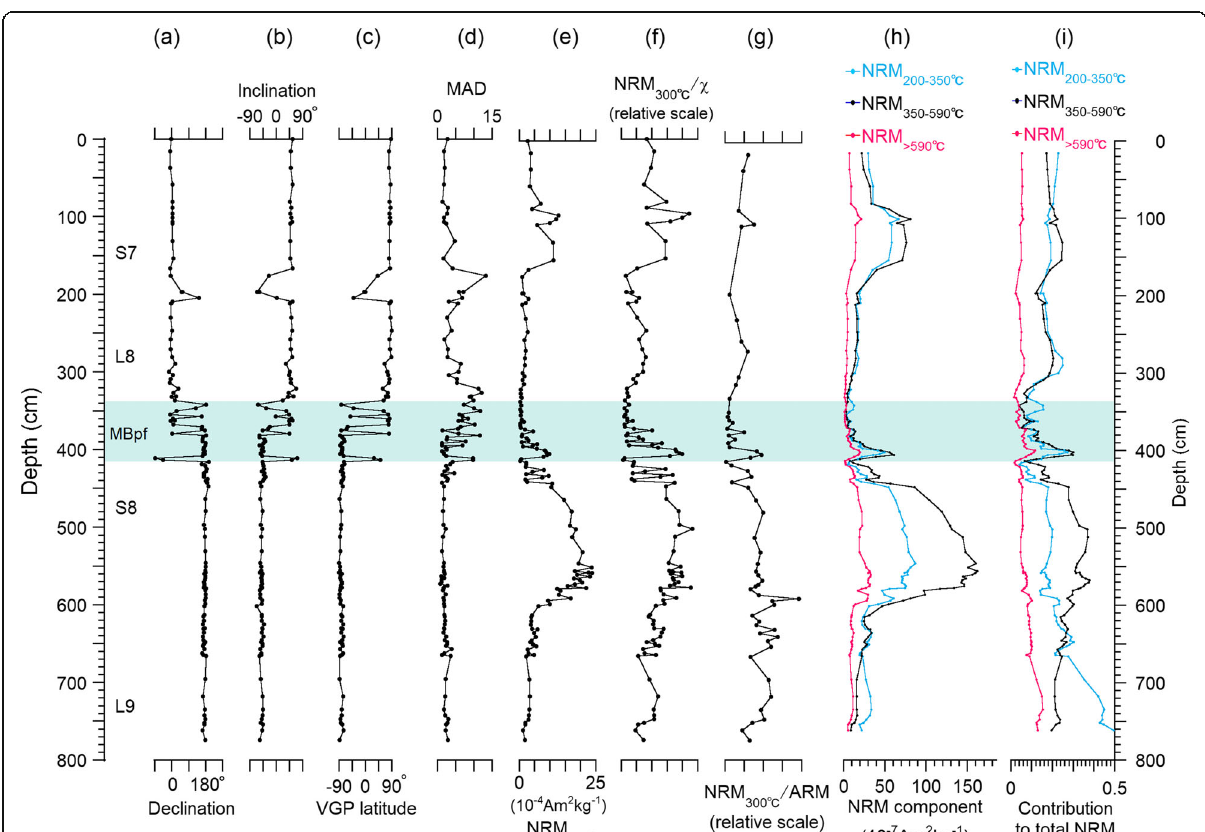
Fig. 4 Paleomagnetic results. a , b Declination and inclination of a ChRM calculated by the principal component analysis. c Latitude of a VGP calculated from the ChRM direction. d MAD (Kirschvink 1980) of the ChRM. e Intensity of NRM after demagnetization at 300 °C (NRM 300 °C ). f Intensity of NRM 300 °C normalized by magnetic susceptibility χ . g Intensity of NRM 300 °C normalized by ARM. h NRM components of temperature ranges of 200 – 350 °C, 350 – 590 °C, and > 590 °C. i Contribution to the total NRM of the components of temperature ranges of 200 – 350 °C, 350 – 590 °C, and > 590 °C. The blue band shows the MB polarity flip zone (see